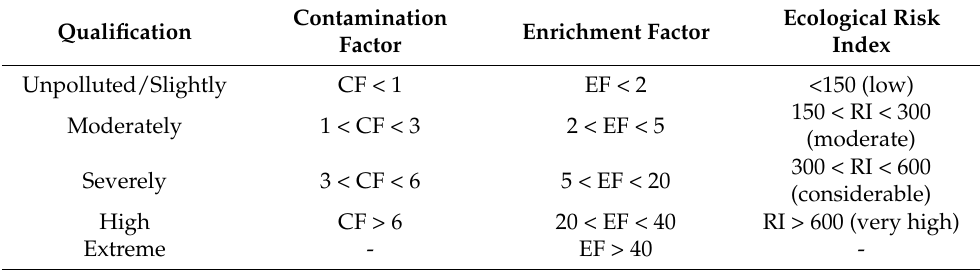
Table 1. Thresholds for sediment quality classification for single and multi-element indices (adapted from